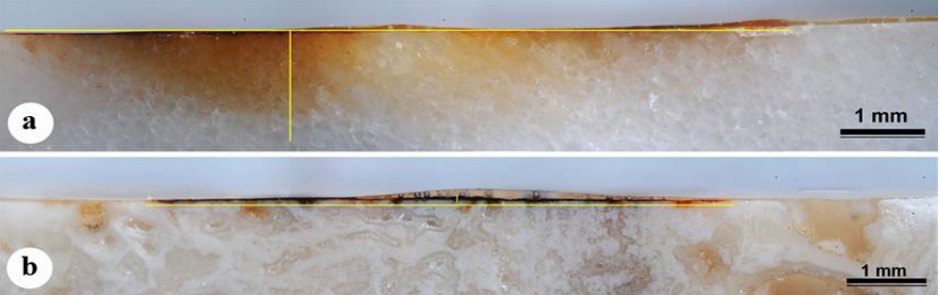
Figure 3. Artificially stained samples. Cross sections images acquired in reflected light (10 × ) of Carrara marble ( a ) and Travertine ( b ) stained outdoors for two seasons (spring and summer).